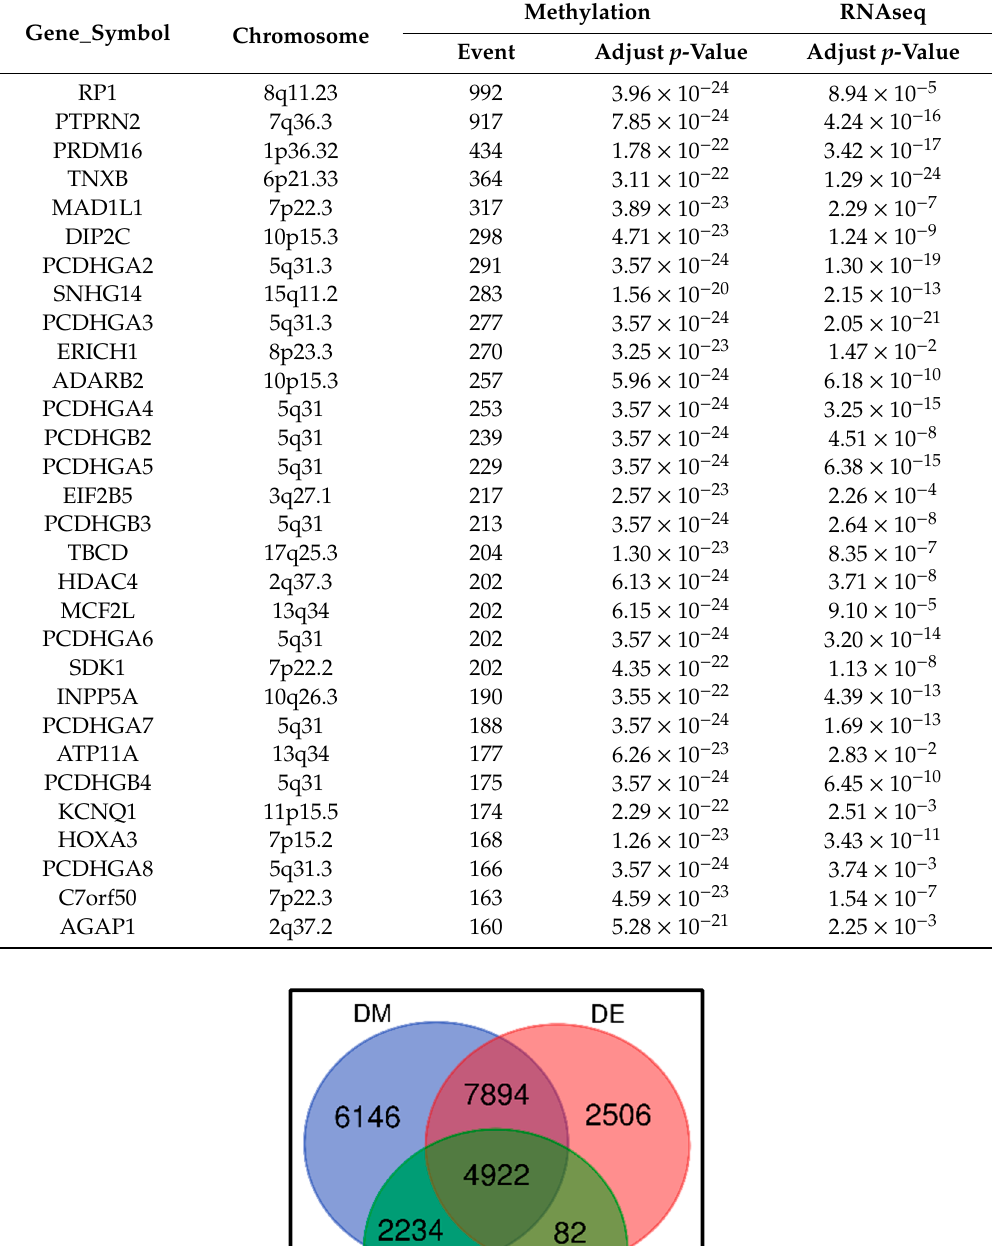
Table 2. A list of the top 30 highly significant di ff erentially methylated genes which were also highly significantly di ff erentially expressed between TNBC and controls. Cancers 2019 , 11 , x